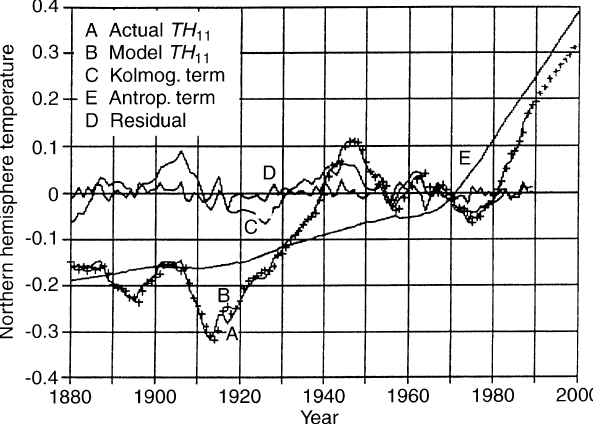
Fig. 8. Northern hemisphere temperature